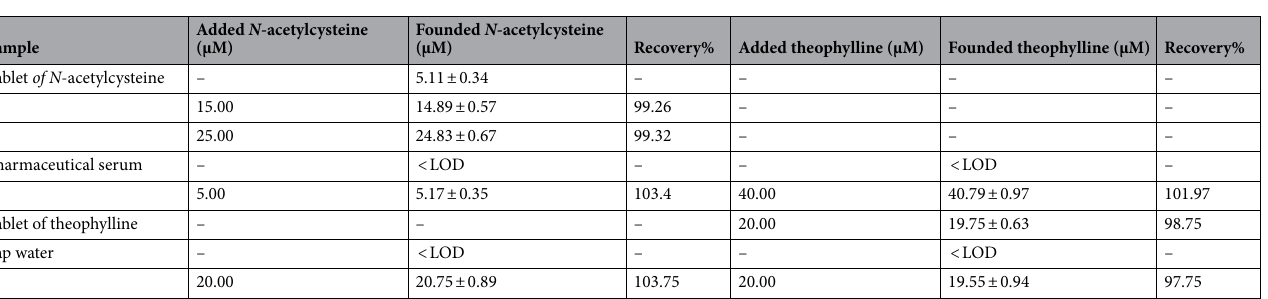
Table 2. Application of BPOFc/BMPF 6 /NiO-SWCNTs/CPE for determination of N -acetylcysteine and theophylline in real sample (n =